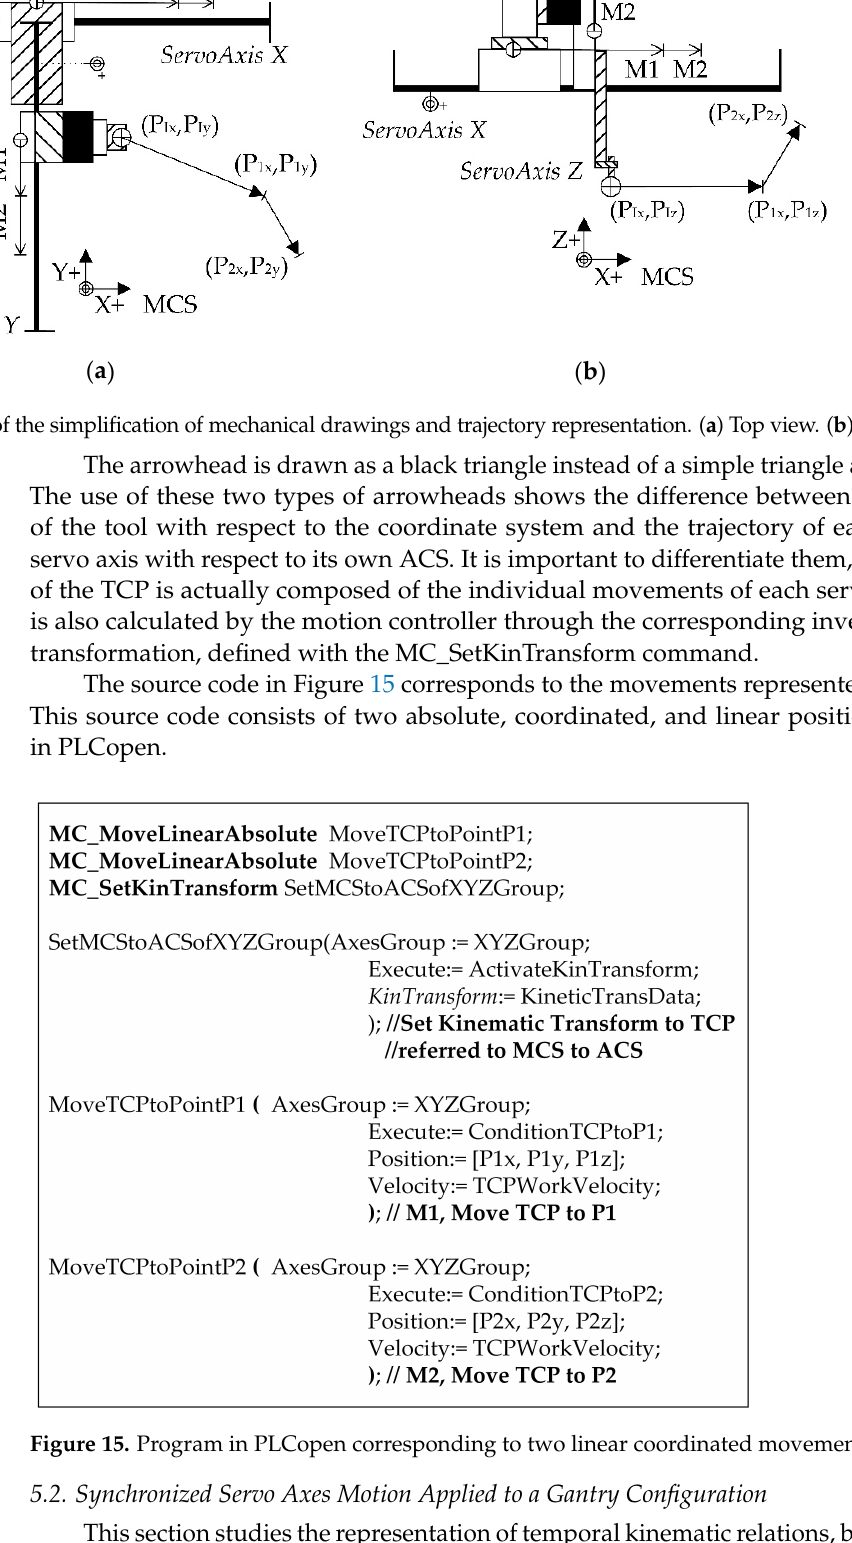
Figure 15. Program in PLCopen corresponding to two linear coordinated